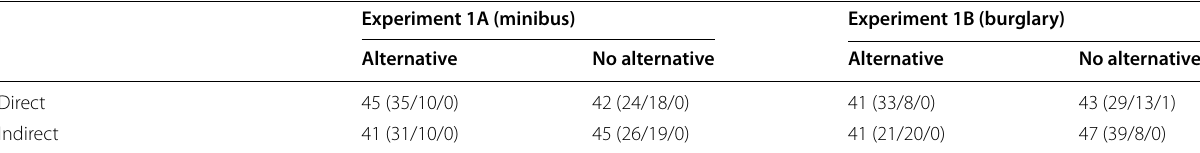
Table 1 Number and Gender Distribution (female/male/do not wish to say) of Participants in Each Condition of Experiment 1A and Experiment